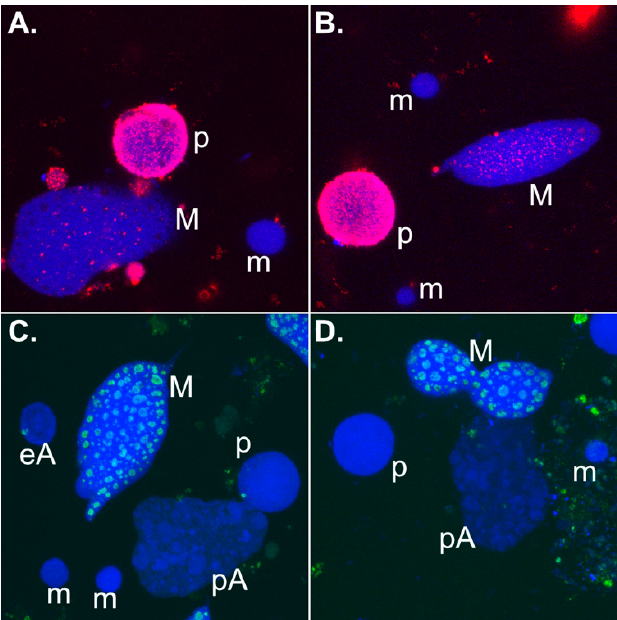
Figure 3. Immunolocalization of nascent RNA and the RNA processing protein fibrillarin in different nuclear types isolated from various developmental stages during Stylonychia sexual reproduction. False colours were assigned to each channel. Abbreviations: p: parental macronuclear fragment; m: micronucleus; M: macronucleus; eA: early macronuclear anlage; pA: polytene macronuclear anlage. ( a,b) Visualization of nascent transcript using 5-FU (red signals). DNA was counterstained with To-Pro-3. ( c , d ) Visualization of fibrillarin using fibrillarin / Nop1p antibodies. DNA was counterstained with To-Pro-3.